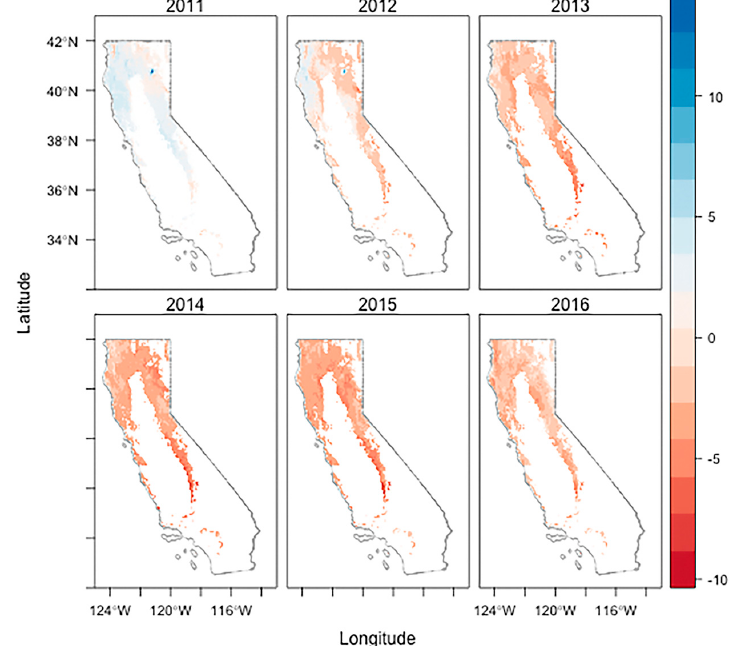
Figure 3. Spatial and temporal patterns in mean annual scPDSI for forested areas in California. Drought condition began in 2012 and intensified and persisted throughout 2016.